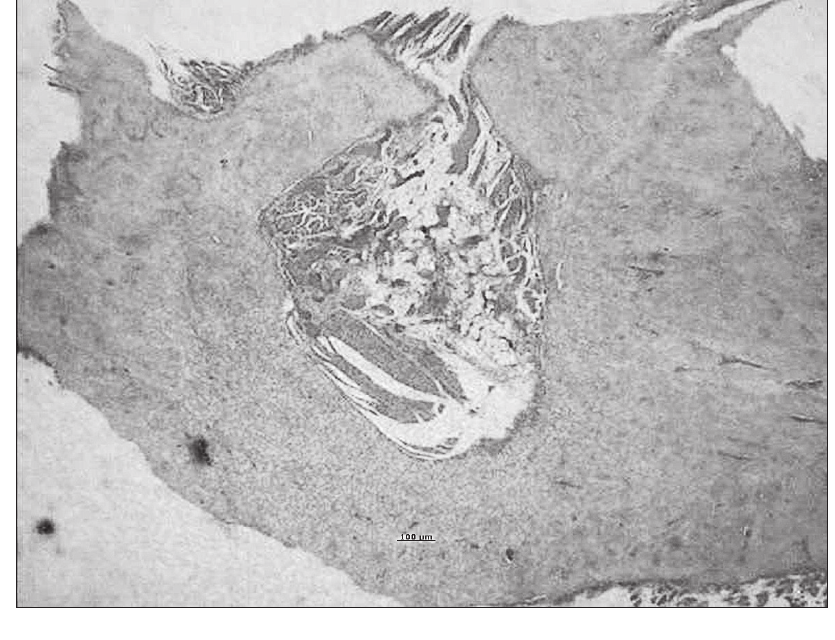
Figure 3 - Histological image of the entire 2 mm defect at the 90 th postoperative day. In this WKY specimen, some osteoblast activity can still be seen in proliferative regions around the defect, although insufficient to achieve closure of the defect.